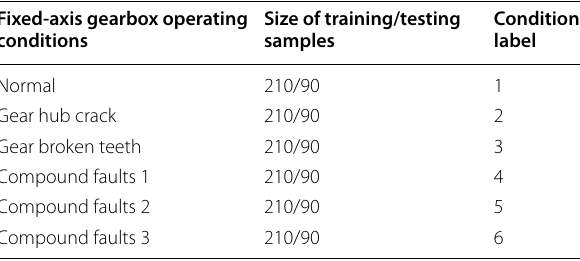
Table 1 Detailed description of the six gearbox conditions